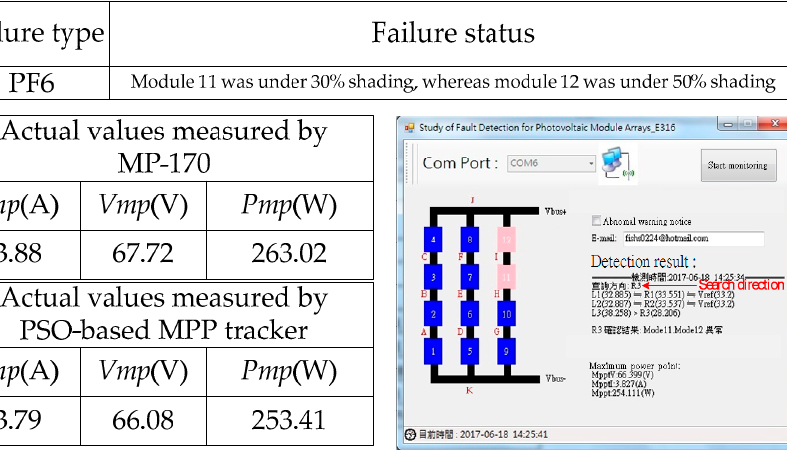
Figure 20. Experimental outcome for failure type PF5.